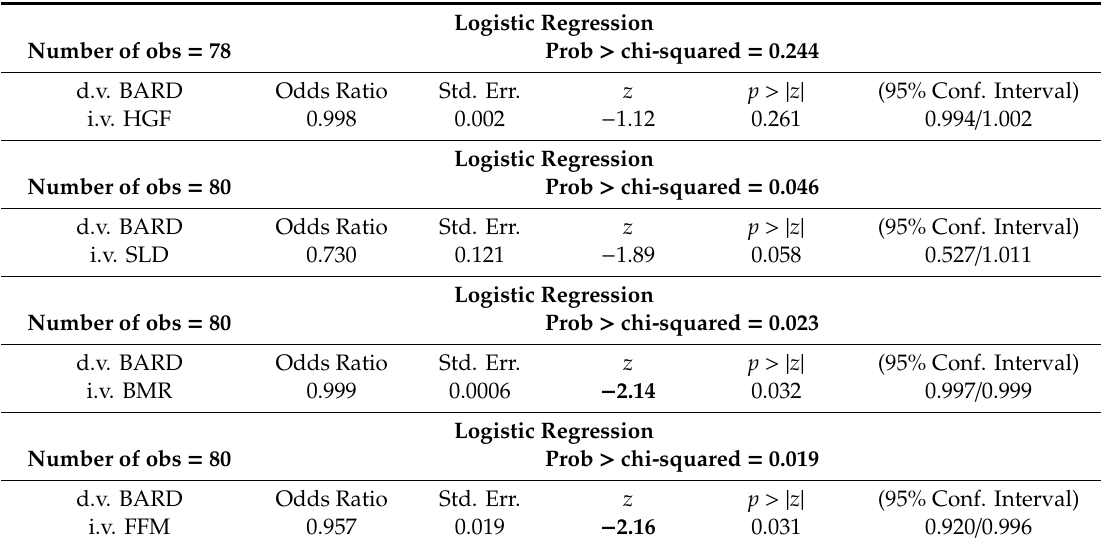
Legend to Table 11: HGF, hepatic growth factor; SLD, spleen longitudinal diameter; BMR, basal metabolic rate; d.v., dependent variable; i.v., independent variable. In bold are highlighted the significant